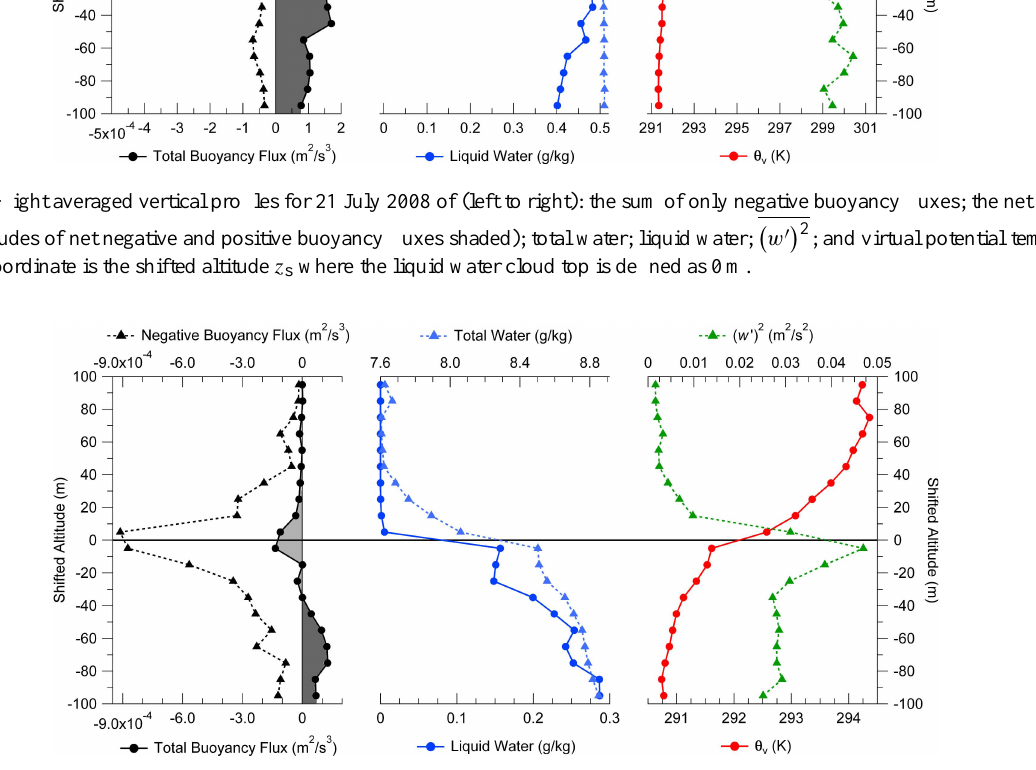
Fig. 3. Whole-flight averaged vertical profiles for 27 July 2008 of (left to right): the sum of only negative buoyancy fluxes; the net buoyancy flux (with altitudes of net negative and positive buoyancy fluxes shaded); total water; liquid water; (cid:0) w 0 (cid:1) 2 ; and virtual potential temperature. The vertical coordinate is the shifted altitude z s where the liquid water cloud top is defined as